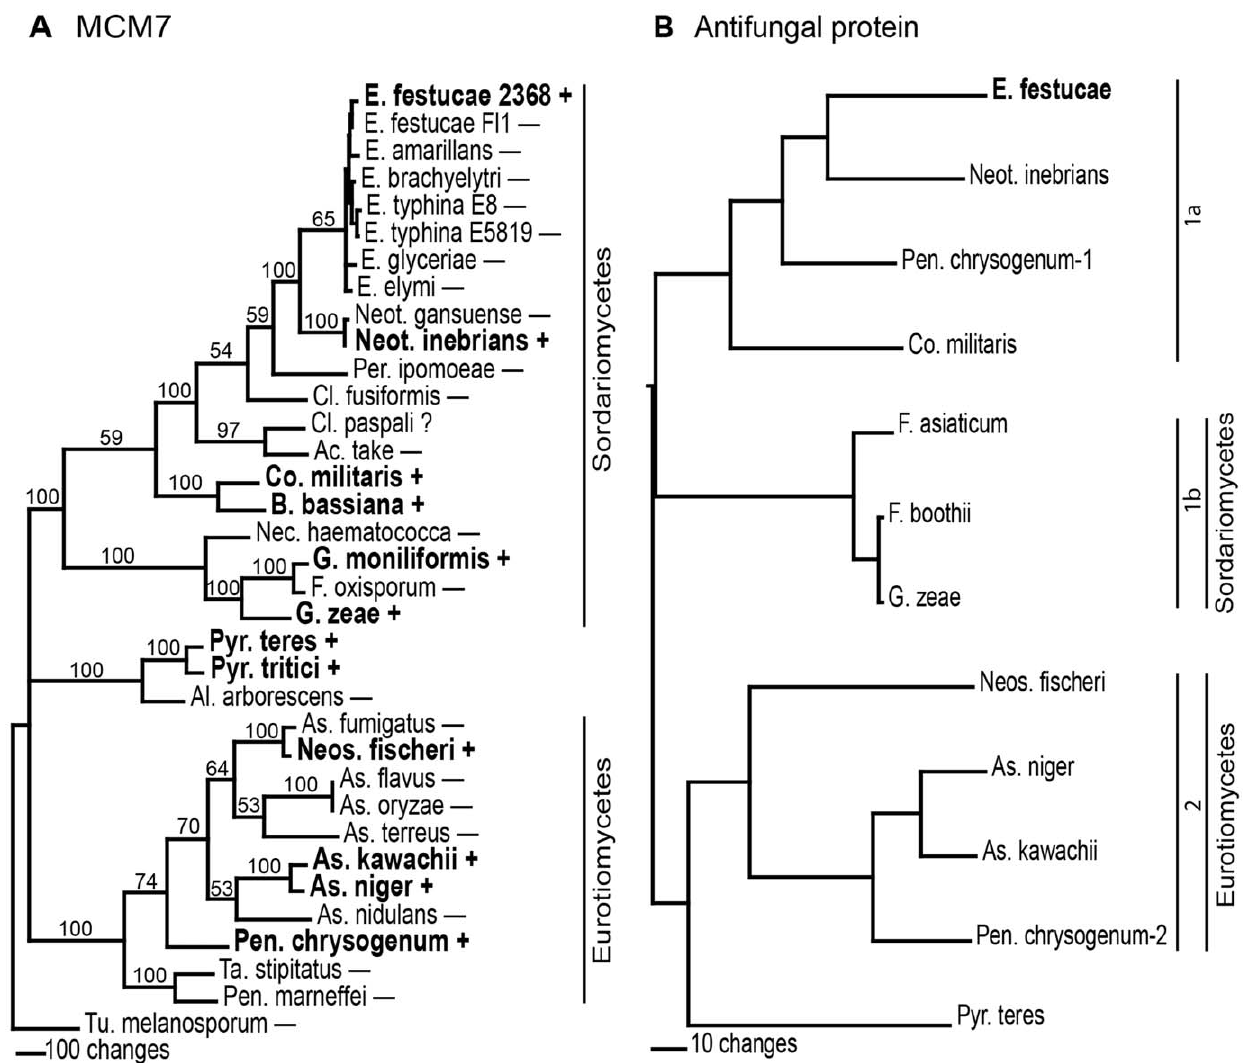
Figure 2. The phylogenetic relationships of the MCM7 and antifungal protein coding sequences. A. Rooted 50% majority rule maximum parsimony phylogenetic tree of the MCM7 coding sequences. The Tu. melanosporum sequence was designated as the outgroup for rooting the tree. The numbers at the nodes are the bootstrap percentages based on 1,000 replications. The presence ( + ) or absence ( 2 ) of an antifungal protein gene is indicated for each species in the tree. B. The single most parsimonious phylogenetic tree recovered from an exhaustive search of the antifungal protein coding sequences. The tree is midpoint rooted. Accession numbers of the sequences used for both trees are given in Table 5.